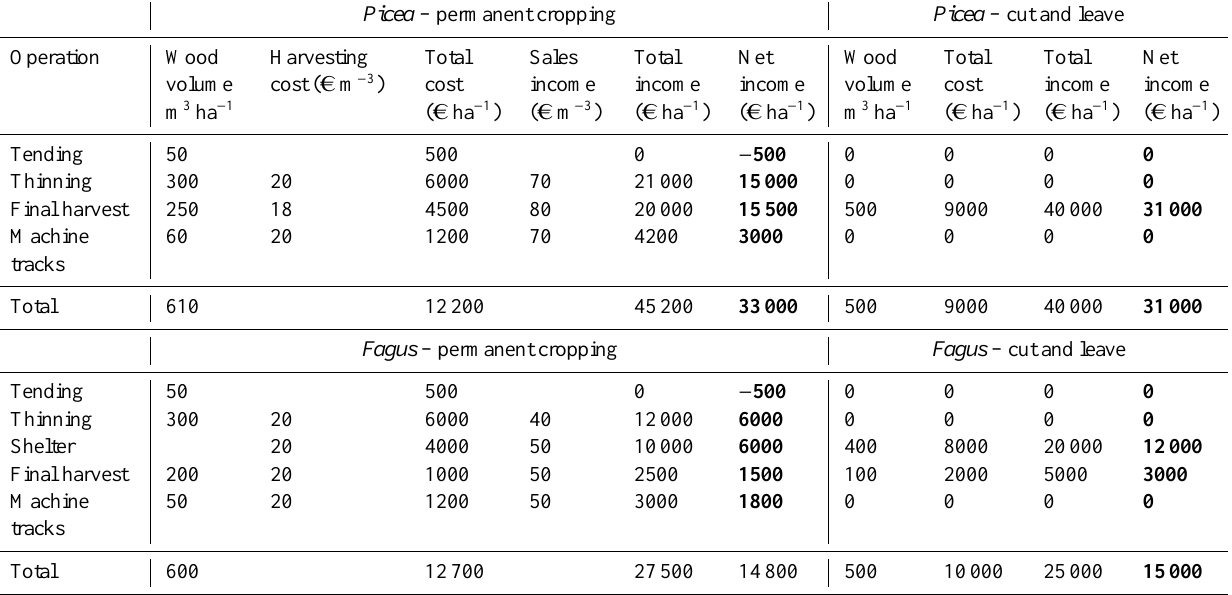
Table 2. Estimated costs and revenues for hypothetical intensive and extensive Fagus and Picea age-class forests in Germany. The costs and revenues are based on data in Thuringia of year 2013, disregarding the cost of capital estimates. The cost of final harvest in Picea is lower than in Fagus because more manual work is required with Fagus . Picea operations are less expensive. The volume estimates are based on Thuringia and on Boisoara forest (Walentowski et al., 2013). The net income is highlighted by bold numbers. The comparison does not consider interest